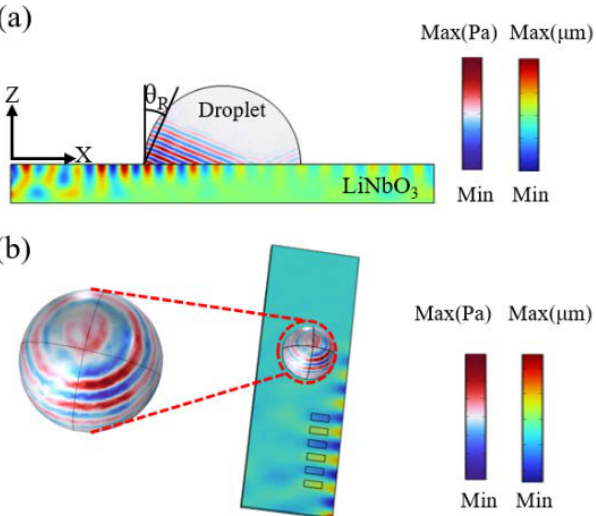
Figure 2. Simulation results of SAWs from the LN surface to scattering into the droplet interior using COMSOL Multiphysics 6.0. ( a ) 2D simulation results in SAWs propagating from left to right along the X -axis of the LN surface and scattering as the Rayleigh angle inside the droplet. θ R is the Rayleigh angle. ( b ) 3D simulation results of forming swirl-like acoustic pressure inside droplets by SAWs.